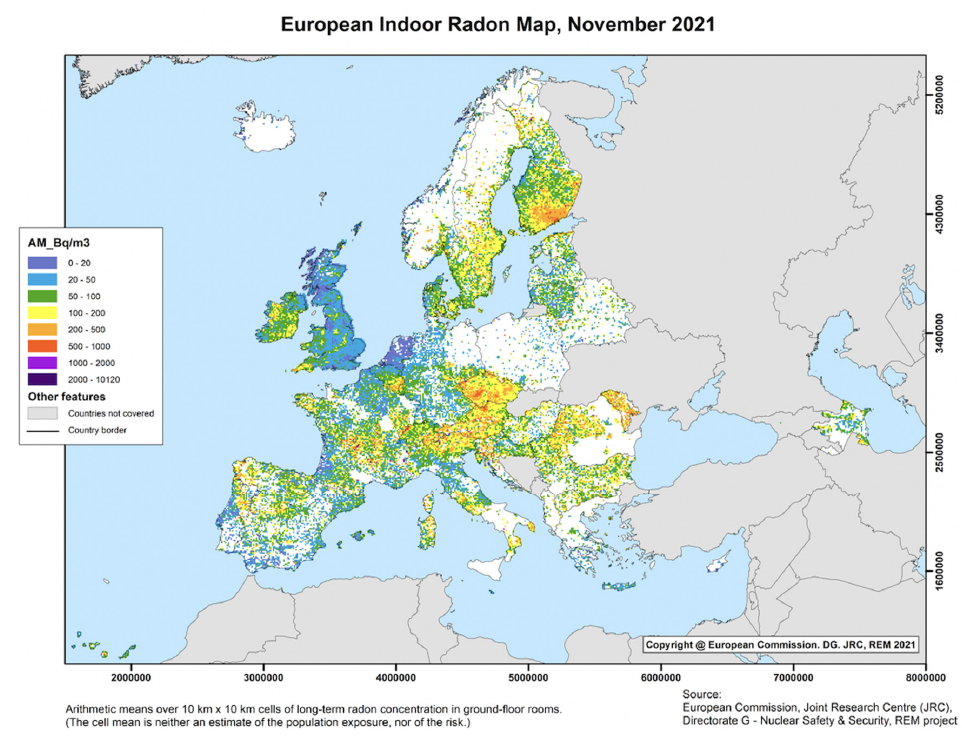
Figure 1. European Indoor Radon Map from the European Commission. Reprinted with permission from the European Atlas of Natural Radiation (EANR), https://remon.jrc.ec.europa.eu/About/Atlas- of-Natural-Radiation/Digital-Atlas/Indoor-radon-AM/Indoor-radon-concentration, accessed on 10 April 2022.